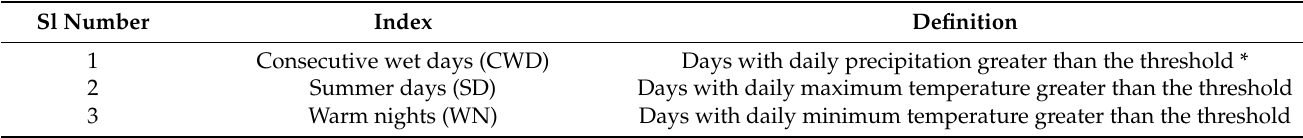
Table 2. Definitions of the extreme